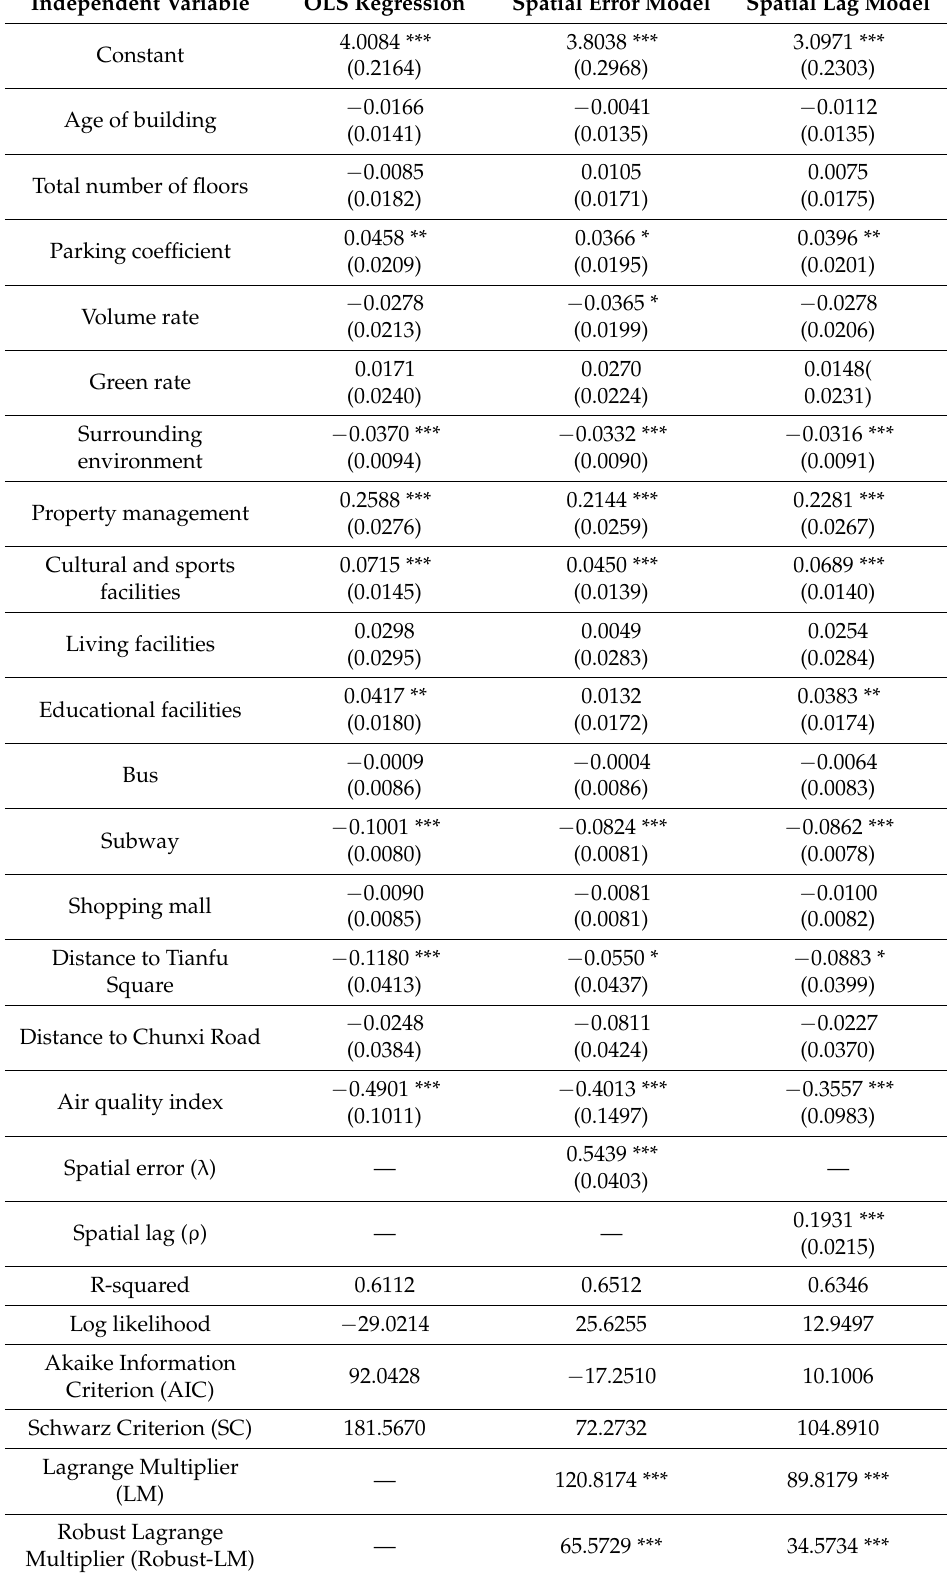
Table 6. OLS regression, Spatial Error Model and Spatial Lag Model results for housing rental prices ( n =